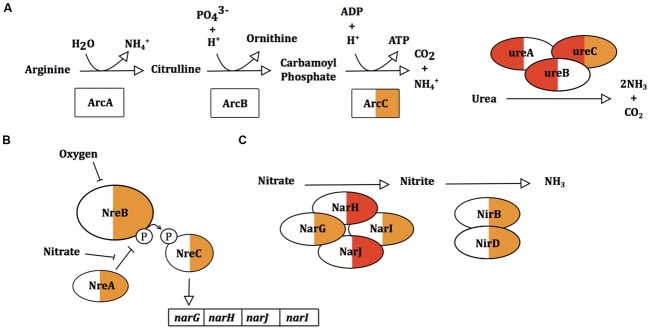
Gene expression changes in ammonia and ammonium producing processes arginine deiminase pathway
(A), urease activity (B) and the nitrate reductase pathway (C) in S. aureus and S. epidermidis. Proteins within pathways are colored for S. aureus Newman (left) and S. epidermidis Tü3298 (right) for changes in gene expression following sapienic acid challenge.